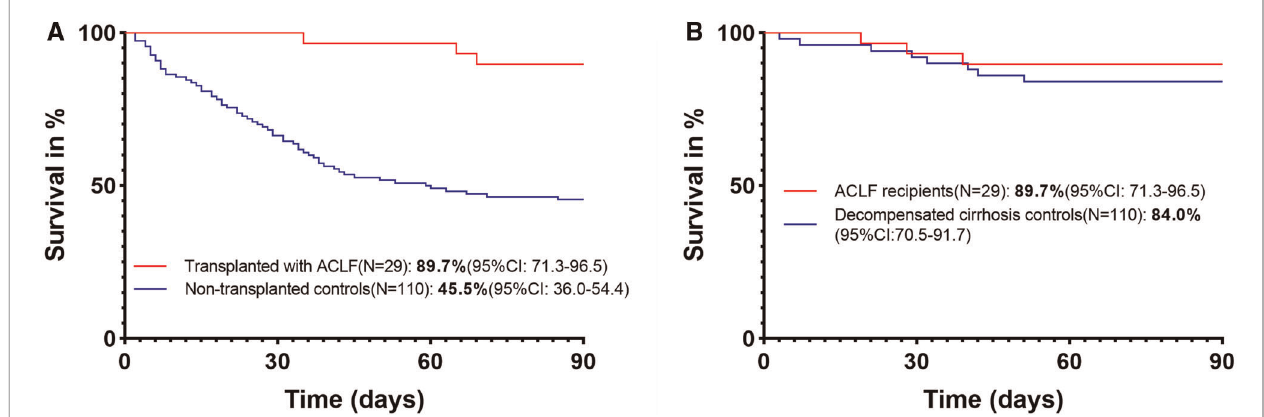
FIGURE 2 | ( A ) 90-day survival of transplanted and nontransplanted ACLF patients. ( B ) 90-day survival of ACLF and decompensated cirrhosis